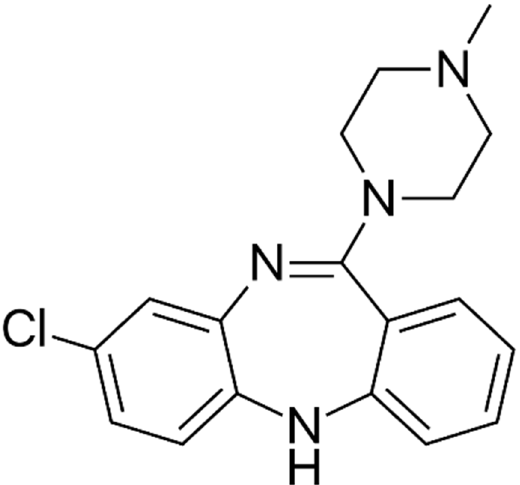
Figure 4. Clozapine chemical structure (IUPAC-C 3-chloro-6-(4-methylpiperazin-1-yl)-11H- benzo[b][1,4]benzodiazepine)